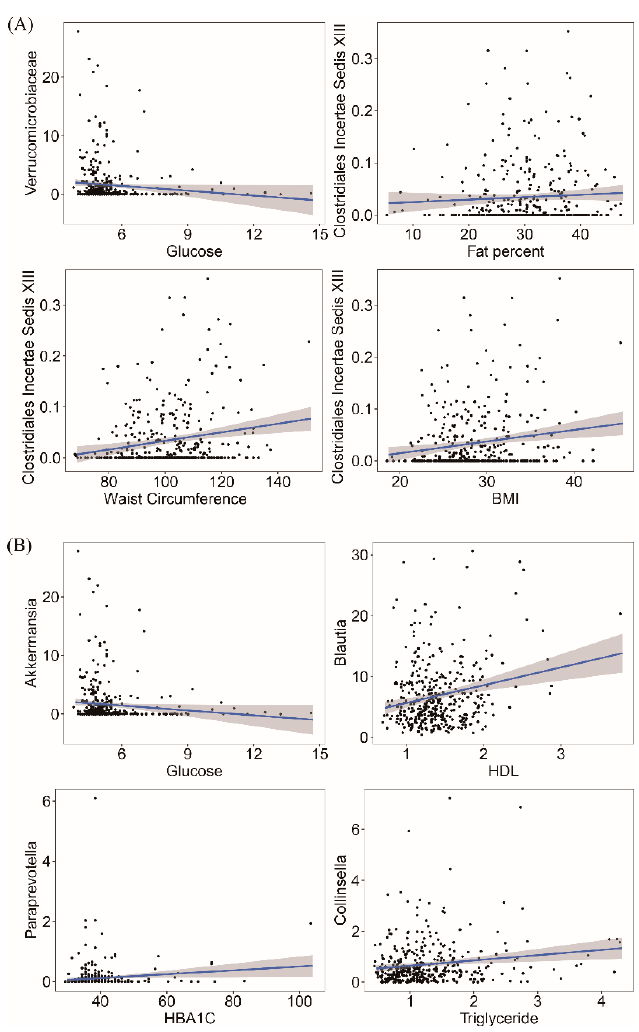
Figure 3. Significant associations between metabolic health markers and taxonomy. Examples of linear regression of metabolic health markers at family level ( A ) and genus level ( B ). Permutational multivariate analysis adjusted for age, sex, disease status (CVD and T2DM), medication use (blood pressure, cholesterol lowering and diabetes medication), lifestyle factors (DASH score, smoking status and alcohol consumption).